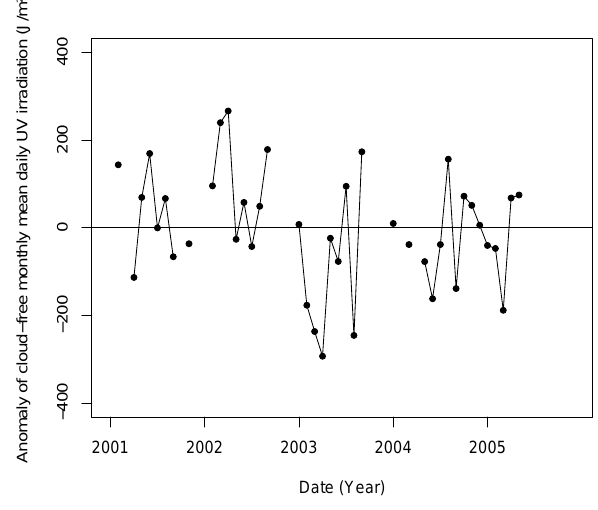
Fig. 2. Evolution of anomaly of cloud-free monthly mean daily ultraviolet erythemal